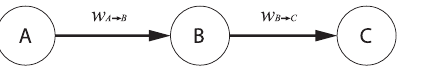
Figure 1. Symbolic representation of the Markov chain under investigation. States are represented as circles and numbered from 0 to 4 according to the scheme outlined in the Materials and Methods section. The arrows N , P ,1 { P , R represent the transition probabilities connecting two different states, while 1 { L and L represent the initial conditions on the states 0,2 .